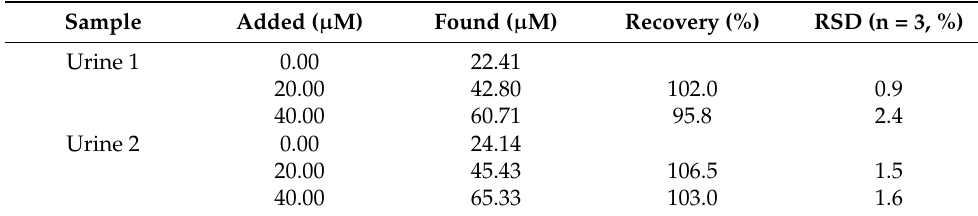
Table 1. Determination of urea in human urine samples.